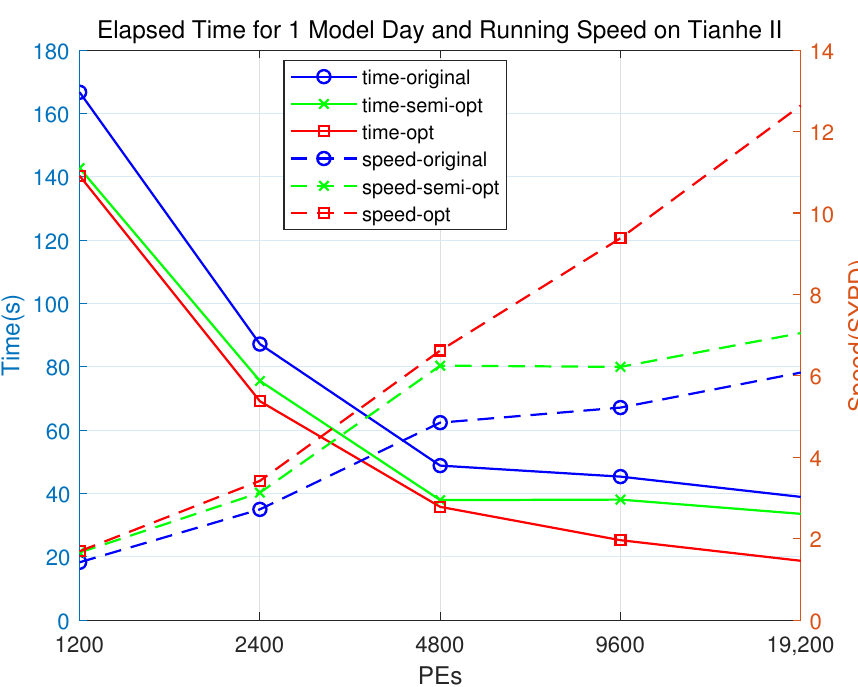
Figure 8. Elapsed time and speed of LICOM on Tianhe